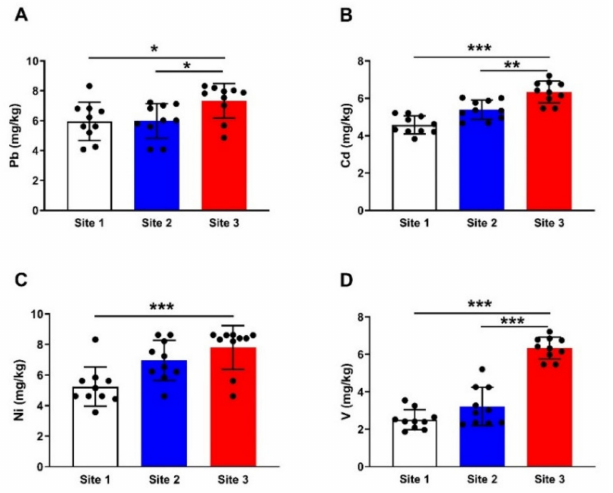
Figure 2. Pb ( A ), Cd ( B ), Ni ( C ), and V ( D ) concentrations in soil samples. Data are mean ± SD ( n = 10). * p < 0.05, ** p < 0.01 and *** p <